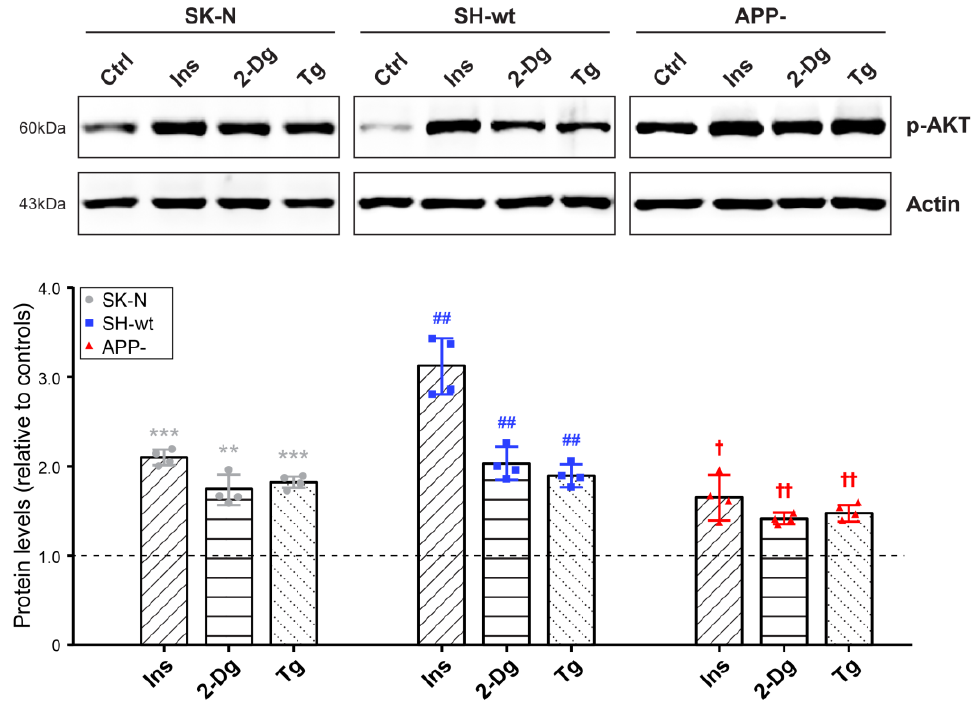
Figure 7. SH-SY5Y/APP- cells display a reduced response to physiological stimuli. Representative immunoblots and quantification of the levels of p-AKT in total protein extracts (30 µ g/lane) from SK-N-SH (SK-N), SH-SY5Y (SH-wt), and SH-SY5Y/APP- (APP-) cells after treatment with 3.5 µ g/mL insulin (Ins), 1 mM 2-Deoxy-d-glucose (2-Dg) or 250 nM thapsigargin (Tg) for 2 h. Actin was used as a loading control for normalization. The molecular weights of the proteins are depicted on the left of each blot image. Data are presented as arbitrary units (a.u.) of the mean ± S.D. pixel intensity of p-AKT bands in treated cells relative to their respective untreated-control cells (Ctrl, set at 1, indicated with a dashed line) from four biological replicates. Dots represent individual data points from four biological replicates. Statistical significance was evaluated by one-way ANOVA followed by Dunnett’s multiple comparison test. “*” is used to depict statistically significant differences between control and treated SK-N cells (* p < 0.05, ** p < 0.01, *** p < 0.001), # between control and treated SH-wt cells (## p < 0.01, ### p < 0.001), while † shows statistically significant differences between control and treated APP- cells († p < 0.05, †† p < 0.01). AKT, Alternative appellation for Protein kinase